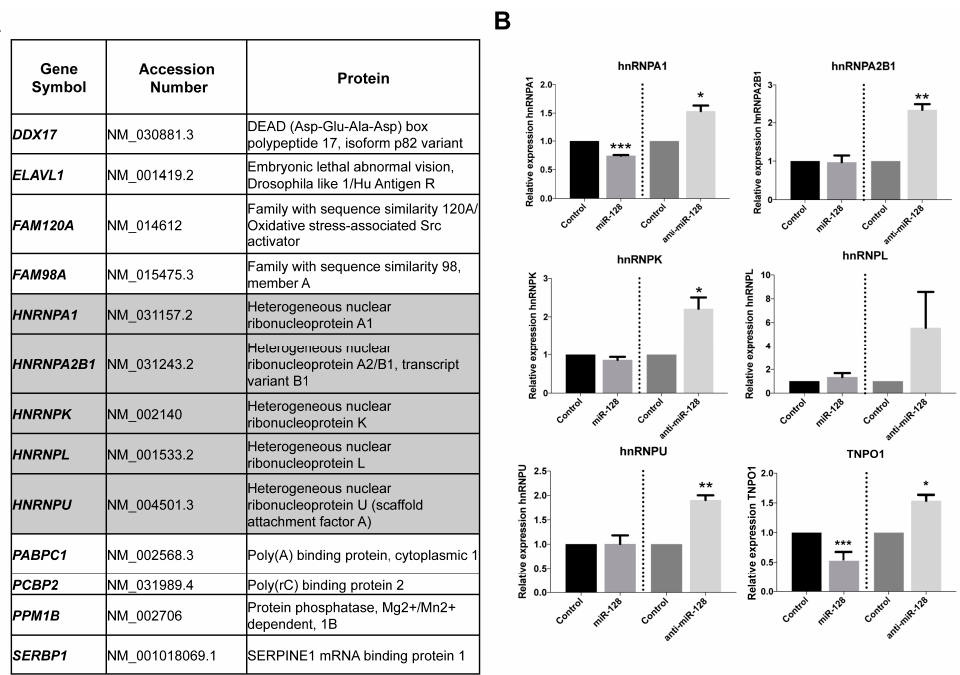
Figure 1. Identification of hnRNPA1 as a cellular target of miR-128. ( A ) Table showing the results of an overlay analysis of the genes identified in our mouse embryonic stem cell (mESC) DGCR8 − / − screen of putative miR-128 targets by differential gene expression and protein targets previously reported as L1 ORF1p interactome [5]. Members of the heterogeneous nuclear ribonucleoproteins (hnRNPs) family of RNA-binding proteins are highlighted in grey, see Supplementary Table S1 for additional information. ( B ) Relative amount of hnRNPA1, hnRNPA2B1, hnRNPK, hnRNPL and hnRNPU and TNPO1 (positive control) mRNA normalized to B2M determined in HeLa cells stably transduced with control miR, anti-miR-128 or miR-128 are shown as mean ± SD ( n = 3 technical replicates, * p < 0.05, ** p < 0.01, *** p < 0.001).